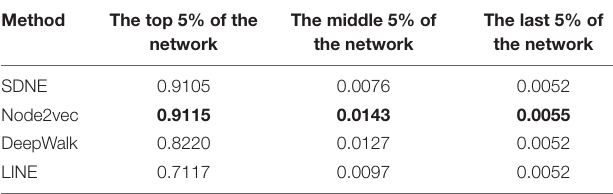
TABLE 2 | AUCPR value of protein similarity prediction in the Human dataset.